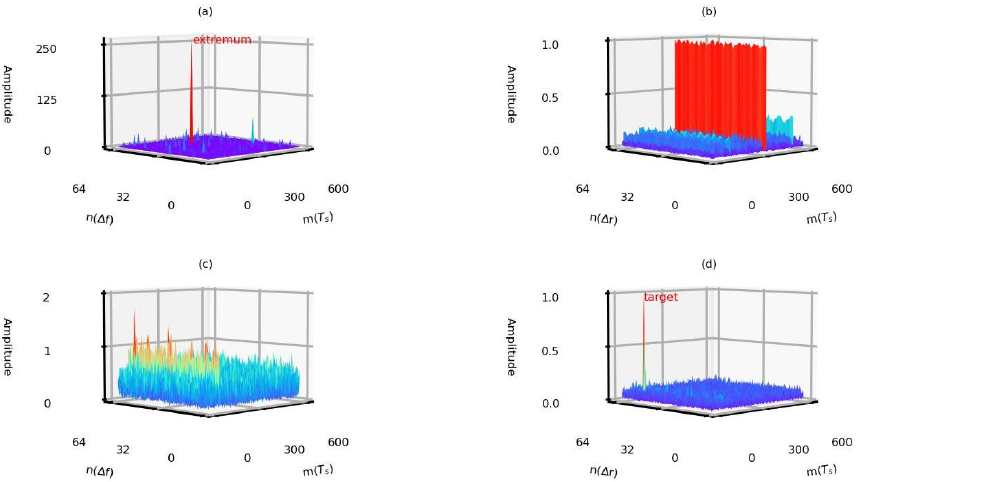
Figure 6. The generated data matrix by the existing method and the proposed method from the echo data based on parameter set 1. ( a ) The obtained data matrix using the existing PCT before applying IDFT. ( b ) The obtained data matrix using the existing PCT after applying IDFT. ( c ) The obtained data matrix using the proposed PCT before applying IDFT. ( d ) The obtained data matrix using the proposed PCT after applying IDFT.